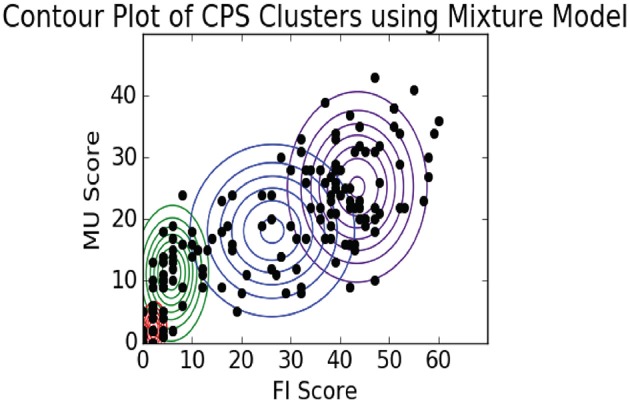
EM contour plot.